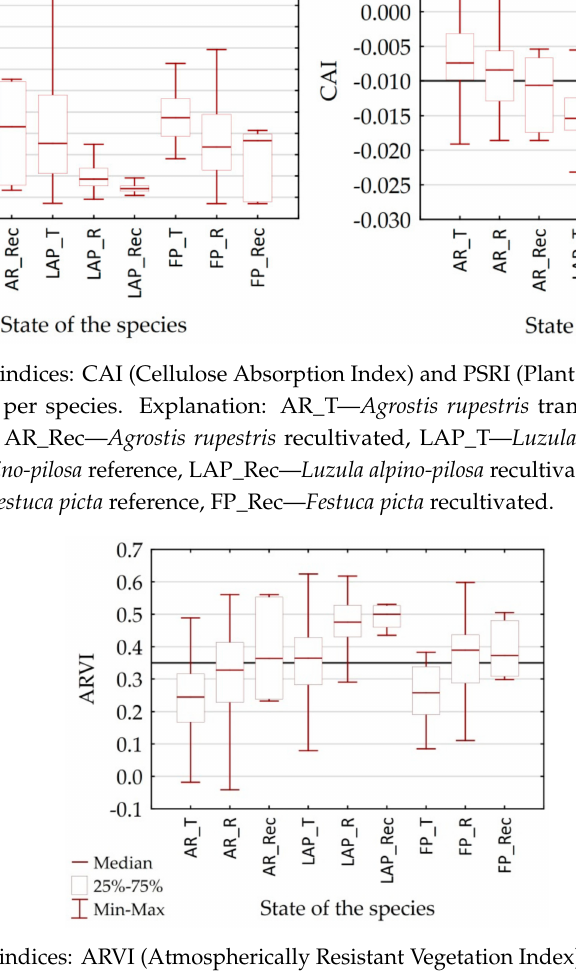
Figure 7. Values of indices: ARVI (Atmospherically Resistant Vegetation Index), n = 49,375 per species. Explanation: AR_T— Agrostis rupestris trampled, AR_R— Agrostis rupestris reference, AR_Rec— Agrostis rupestris recultivated, LAP_T— Luzula alpino-pilosa trampled, LAP_R— Luzula alpino-pilosa